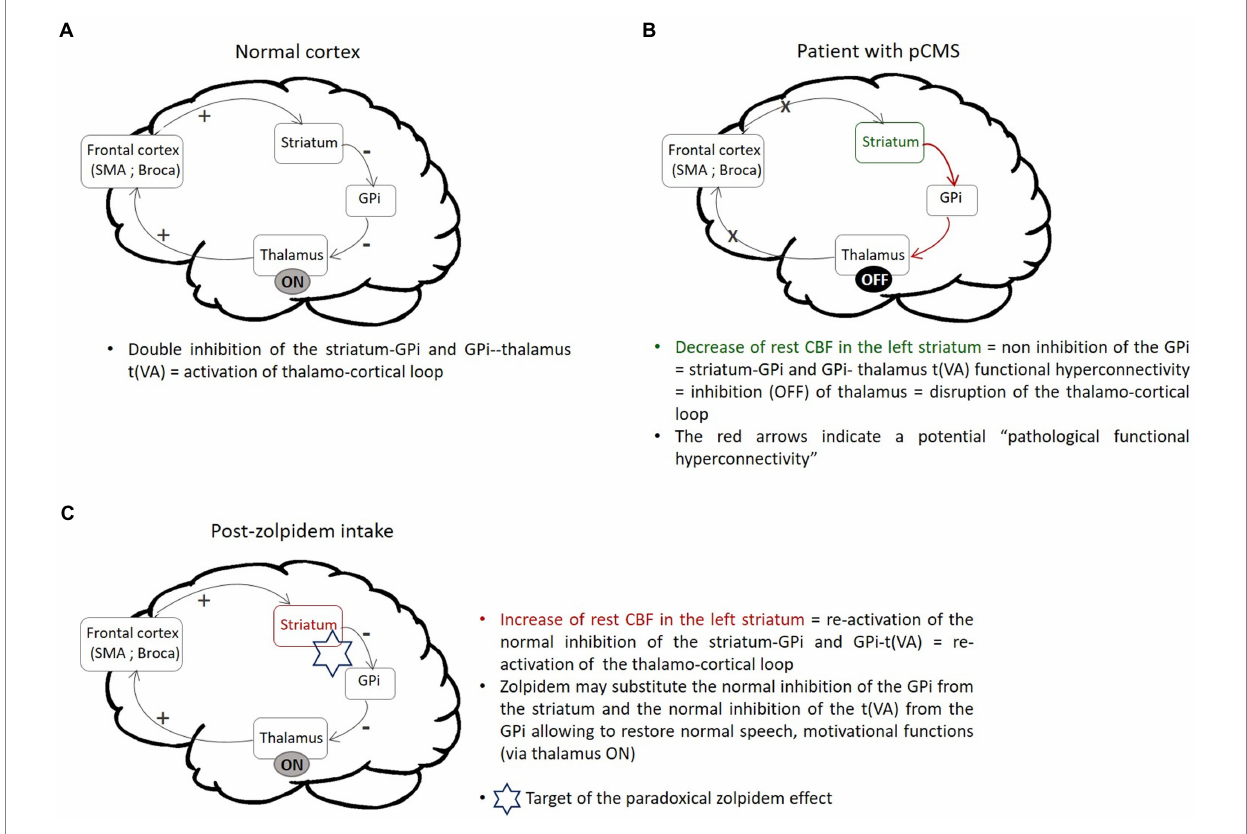
FIGURE 3 Schematic illustration summarizing the hypothesis for the mechanism of action of the paradoxical effect of zolpidem in pCMS. (A) Illustration of the activation of the thalamo-cortical loop in the normal cortex. The frontal cortex activates the striatum. The striatum then inhibits the GPi neurons, which in turn inhibit the t(VA). Such double inhibition from the striatum induces disinhibition (double inhibition = activation) of the thalamus, promoting the excitatory influence of the thalamus on the prefrontal cortices. (B) Illustration of the disruption of the thalamo-cortical loop observed in pCMS. The decreased rest CBF observed in the left striatum in the immediate postoperative ASL images may lead to non-inhibition of the GPi, which would affect the connectivity of the striatum-GPi and GPi-t(VA) (“pathological” hyper striatum-GPi and GPi-t(VA) FC) and prevent activation of the thalamo-cortical loop. (C) Illustration of the reactivation of the thalamo-cortical loop after zolpidem intake. The increased rest CBF in the left striatum after zolpidem intake may induce reactivation of the normal double inhibition of the GPi from the striatum and the t(VA) from the GPi, therefore re-activating the thalamic influence on the prefrontal cortex, restoring normal speech, motivation, and emotional functions. pCMS, postoperative cerebellar mutism syndrome; SMA, supplementary motor area, globus pallidus; GPi, internal globus